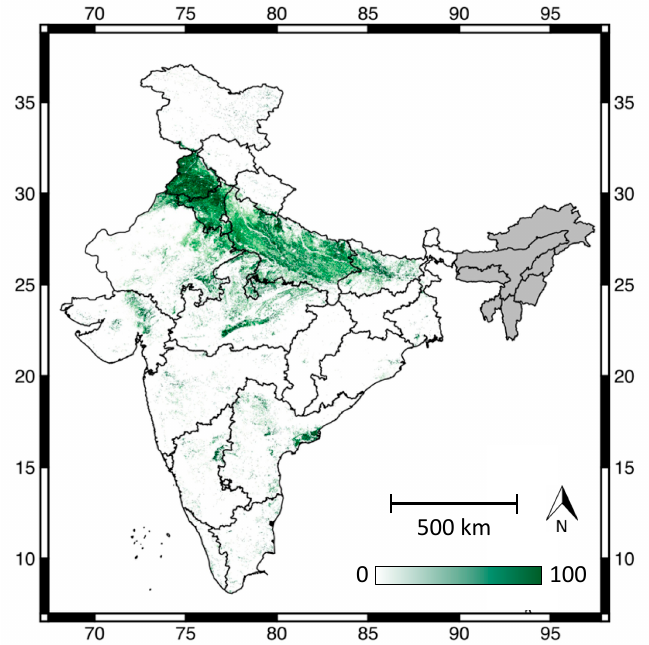
Figure 5. Cropped area map for 2000–2001 using our MSA derived product at a 1 × 1 km 2 resolution. Non-cropped areas are highlighted in white and 100% cropped pixels are highlighted in dark green. States that were not considered in our study are shaded in gray.